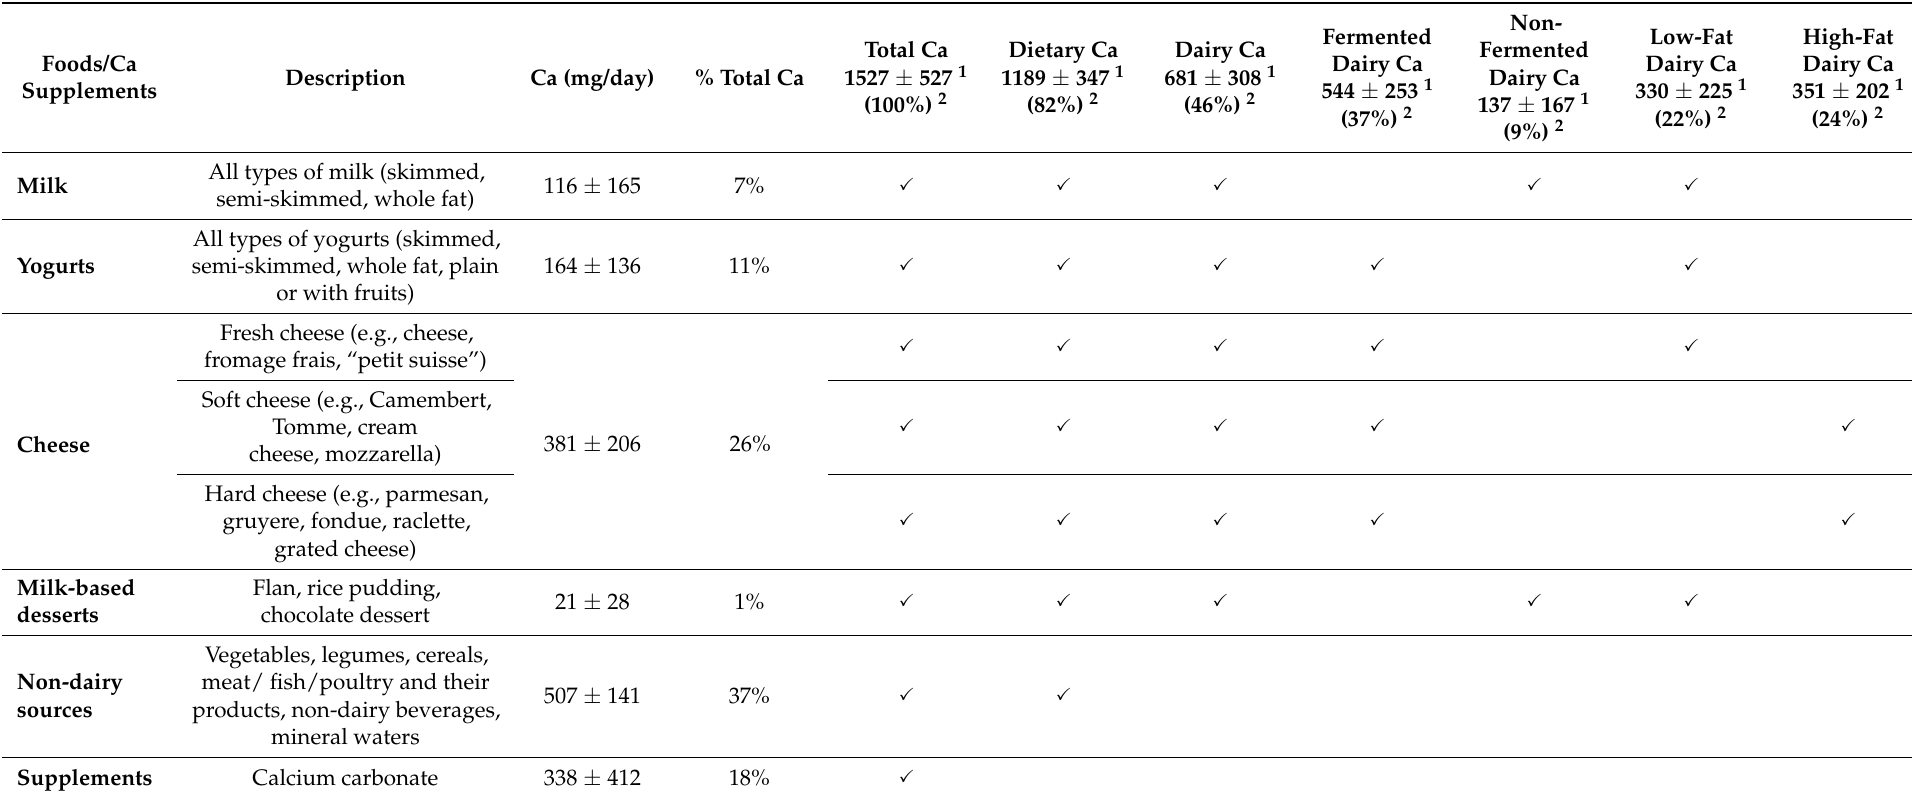
Table 1. Classification of calcium sources (dietary sources & supplements) and their contributions to total calcium intake (in mg/day and %).